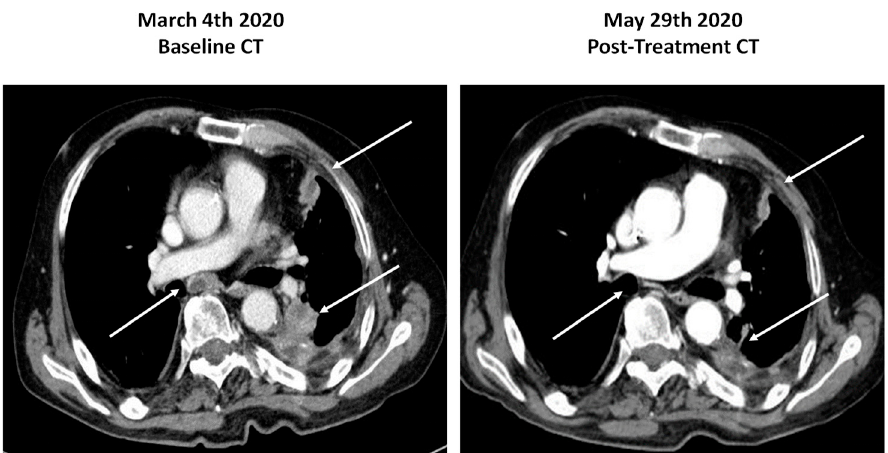
Figure 2. CT scans of the lung lesions before and after chemotherapy with carboplatin and pemetrexed. Arrows highlight the significant response to therapy of mediastinal, pleural, and lung lesions.